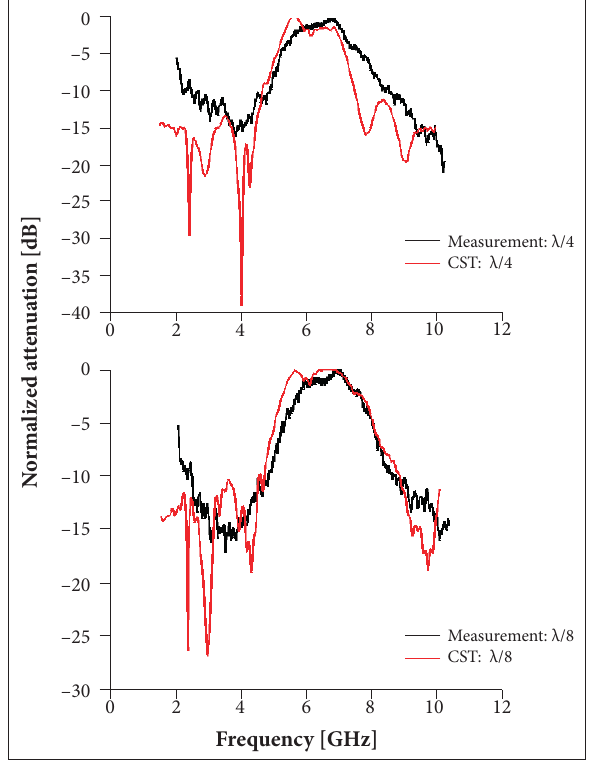
Figure 10. Measurement and simulation of the single array. (a) Distance λ /4 and (b) λ /8.